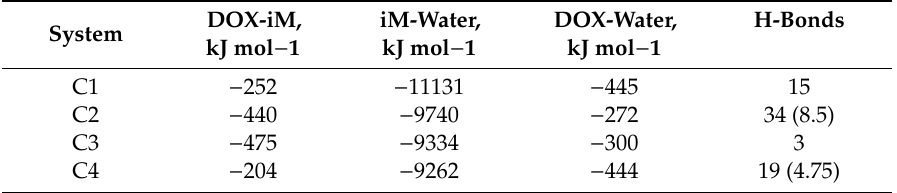
Figure 5. Optimal configurations found for (C1) one DOX molecule interacting with iMu; (C2) four DOX molecules interacting with iMu; (C3) one DOX molecule interacting with iMp; and (C4) four DOX molecules interacting with iMp. Table 3. Mean pair interaction energies between various systems components. The energies are calculated per single DOX molecule. The column H-bonds informs about the number of hydrogen bonds observed between DOX and iM during the last 10.8 ns of calculations (in parentheses the number of H-bonds per single DOX molecule is